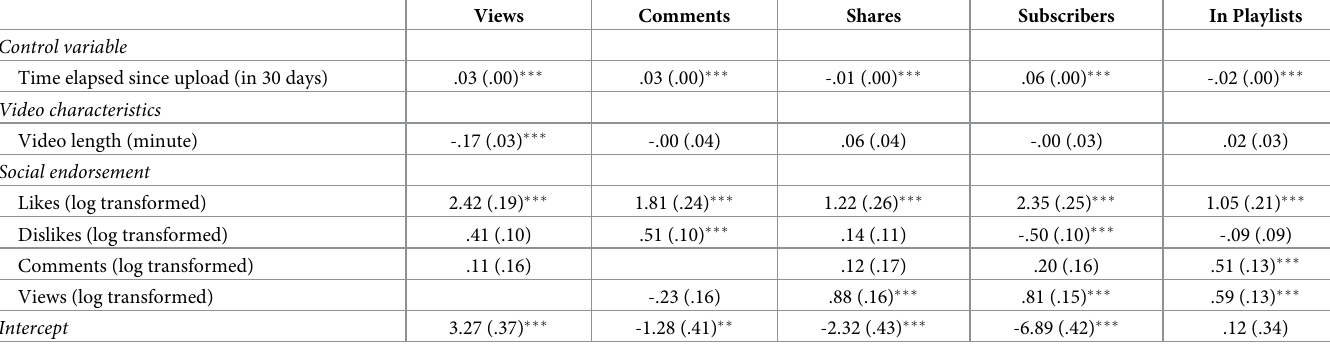
Table 5. Correlates of variations in science video views, shares, comments, subscribers gained, and playlists added in ( N =